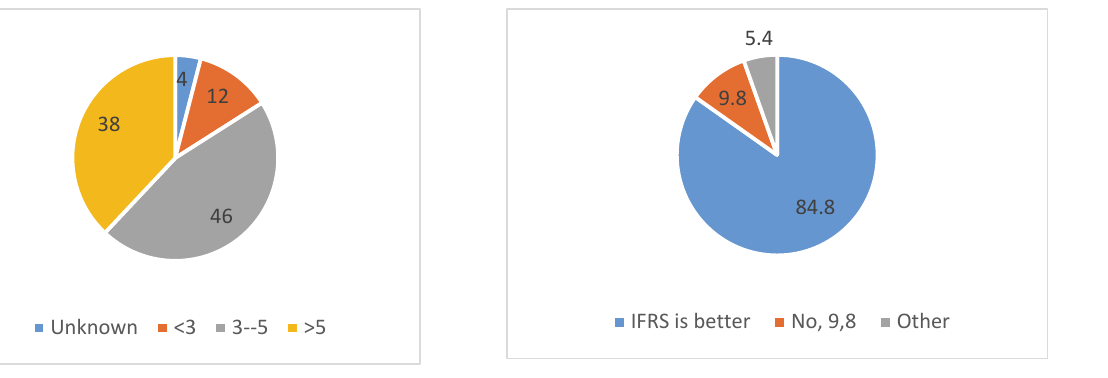
Fig. 3. IFRS application roadmap in Vietnam Fig. 4. IFRS are better than